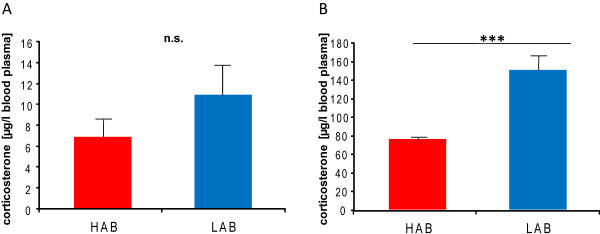
Corticosterone levels in the blood plasma of male HAB vs. LAB mice (A) under basal conditions, (B) after a 15-min restraint stressor. Data are shown as mean ± standard error of the mean (SEM) with N (HAB) = 12 and N (LAB) = 11; *** p < 0.001.